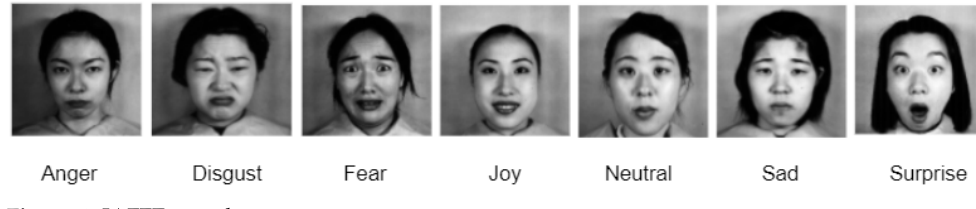
Figure 4. JAFFE samples.